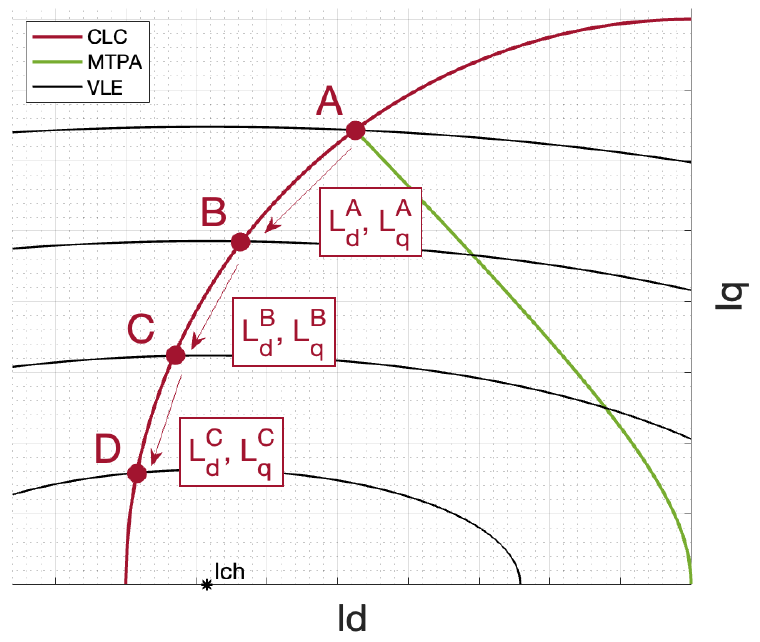
Figure 7. Procedure of the FW algorithm on the d-q reference plane